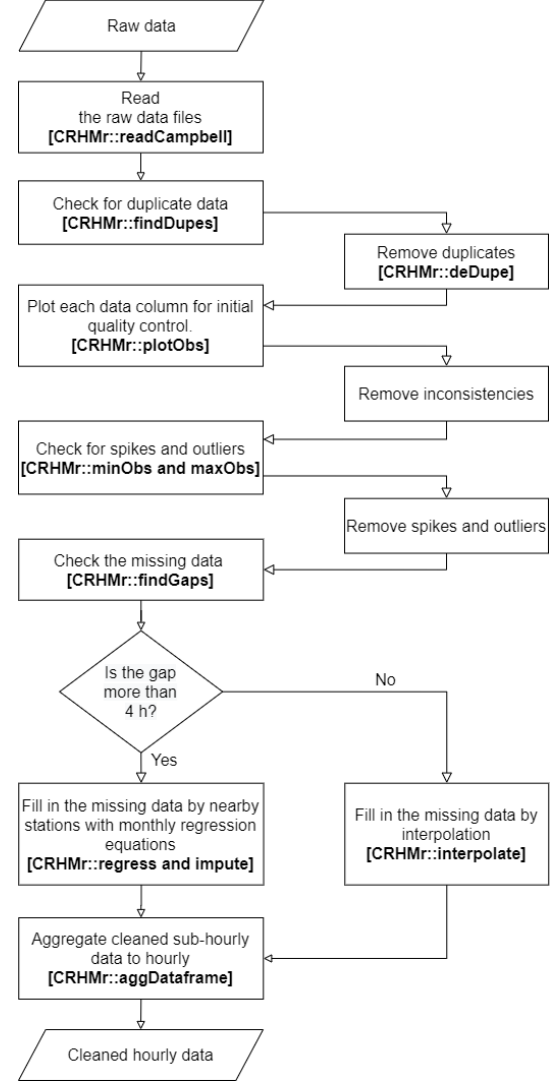
Figure 11. Meteorological data cleaning process with